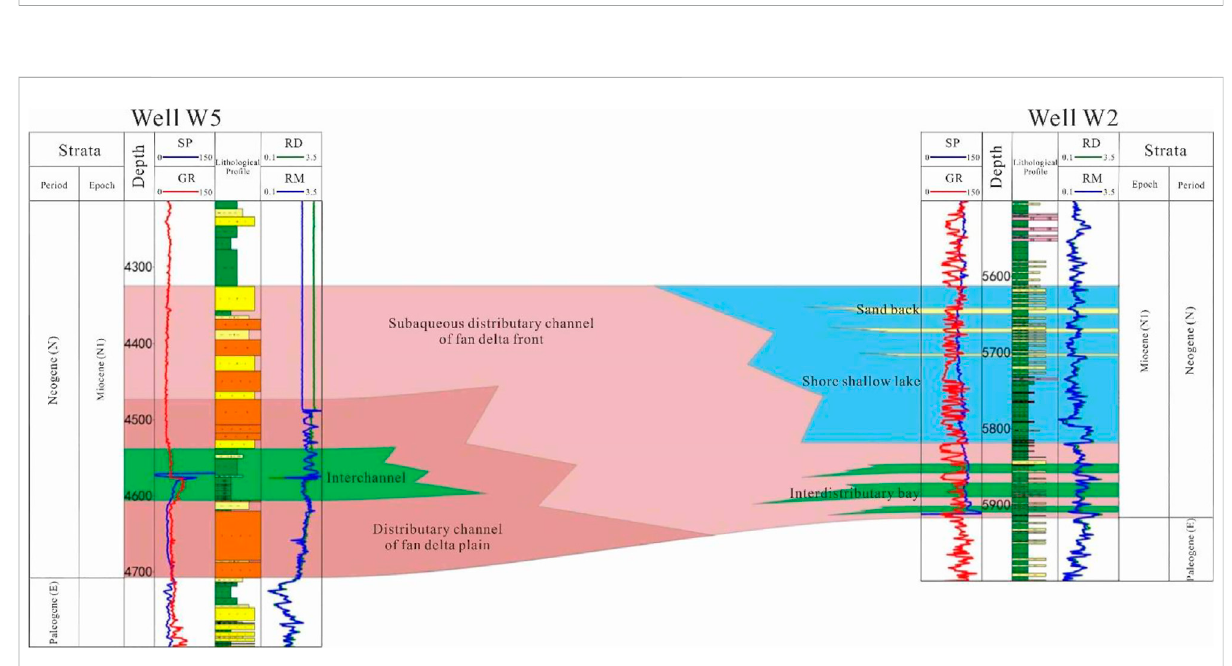
FIGURE 3 Comparison of sedimentary connected Wells of Keziluyi Formation in Well